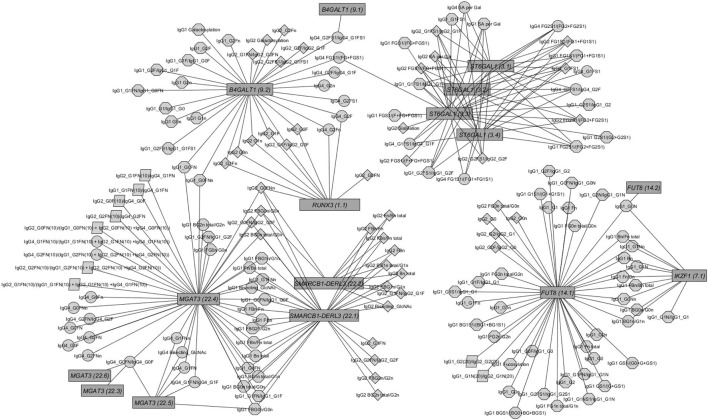
Network of replicated associations immunoglobulin G (IgG) glycan traits (circles) for different subclasses (octagon: IgG1; diamonds: IgG2; circles: IgG4; parallelogram: subclass comparisons) and their associations to the seven replicated loci (edges only for replicated results).